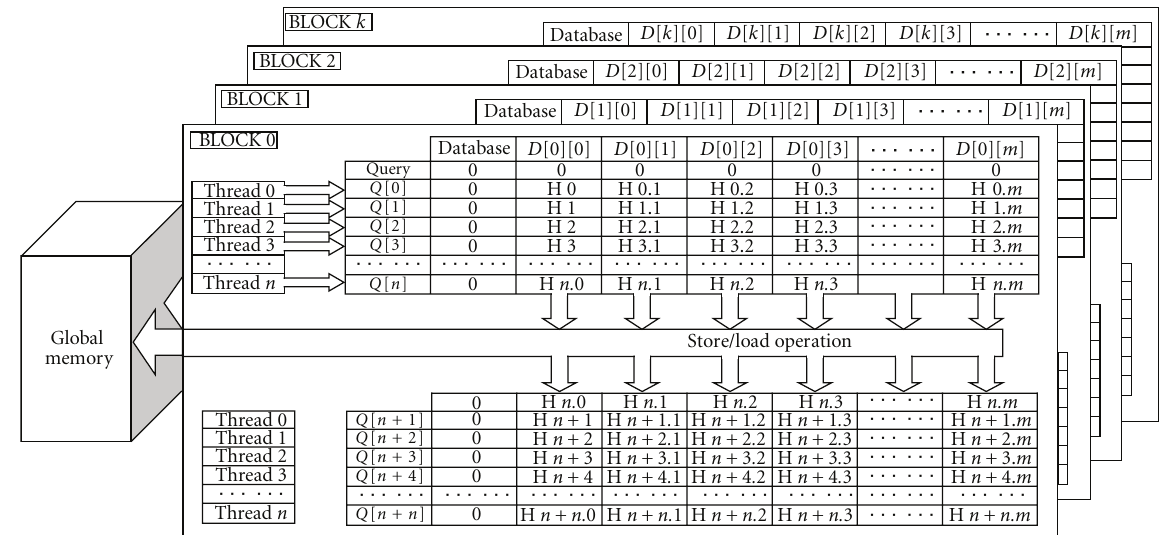
Figure 9: Our GPU parallel thread implementation of the Smith-Waterman algorithm: store and load operations are performed by the final thread and the first thread in each thread batch (block) to allow for any sequence length processing.